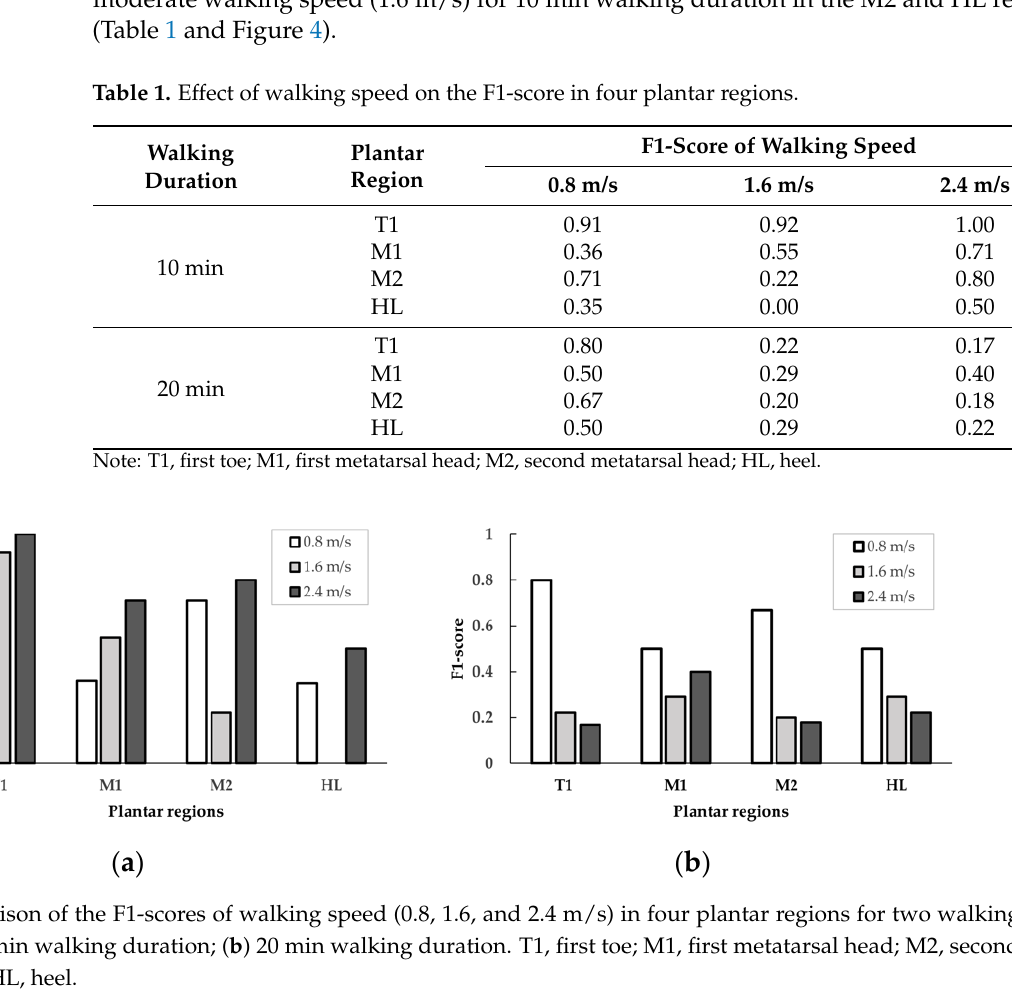
Table 1. Effect of walking speed on the F1-score in four plantar regions.